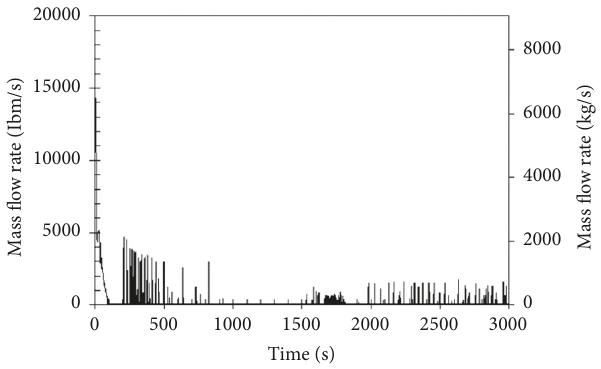
Figure 13: 10-inch liquid break discharge (NOTRUMP code)